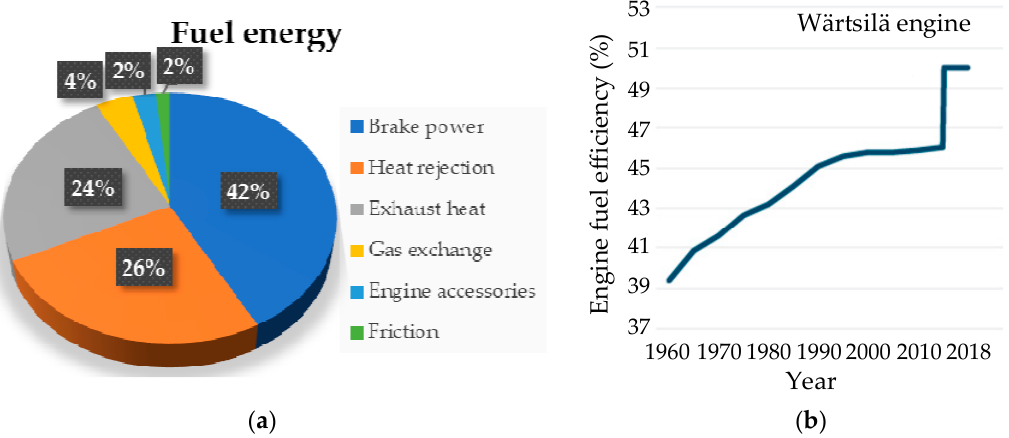
Figure 3. Energy efficiency of engines: ( a ) a typical diesel engine in 2009; ( b ) Wärtsilä engine fuel efficiency development.